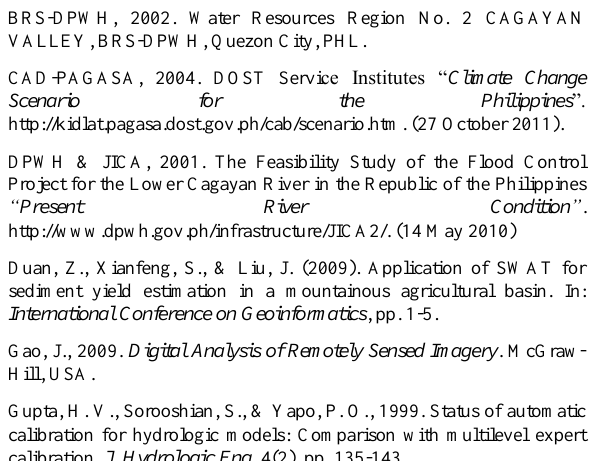
Figure 7. The HRUs where mitigation measures (afforestation and reforestation) were applied. Alibuyog, N. R., Ella, V. B., Reyes, M. R., Srinivasan, R., Heatwole, C., & Dillaha, T., 2009. Predicting the Effects of land Use on Runoff and Sediment Yields in Selected Sub-watersheds of the Manupali River Using the ArcSWAT Model. Soil and Water Assessment Tool (SWAT): Global Applications, pp.